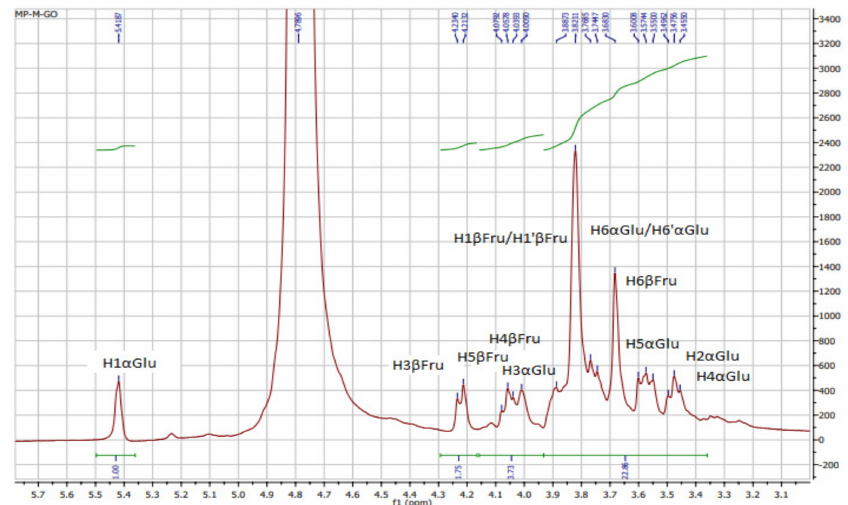
Figure 1. 1 H NMR spectra of polysaccharides from Ceratonia siliqua kibbles.